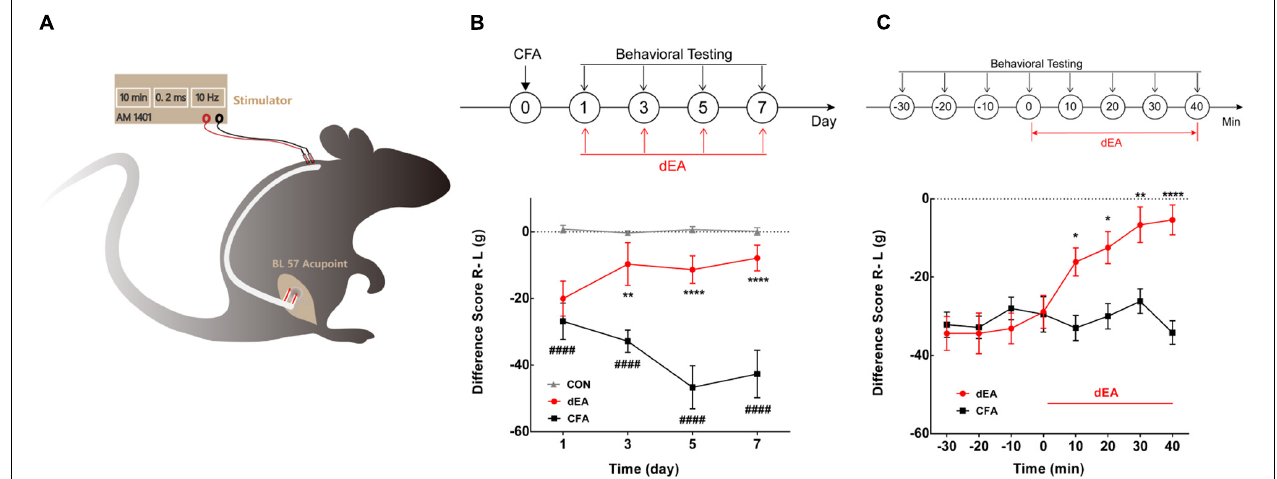
FIGURE 1 | Deep electroacupuncture (dEA) ameliorated complete Freund’s adjuvant (CFA)-induced inflammatory muscle pain behavior. (A) Setup for dEA at the BL57 acupoint under free-moving condition. (B) The difference score for weight-bearing significantly reduced for 7 days after CFA injection and accumulated four times dEA markedly increased the difference score. #### p < 0.0001 vs. CON, ** p < 0.01, or **** p < 0.0001 vs. CFA, significant difference between groups at each time point (Holm–Sidak post-test, n = 6). (C) The difference score for weight-bearing gradually increased and lasted during 40 min dEA stimulation. * p < 0.05, ** p < 0.01, or **** p < 0.0001, significant difference between groups at each of the indicated time points (Holm–Sidak post-test, n =